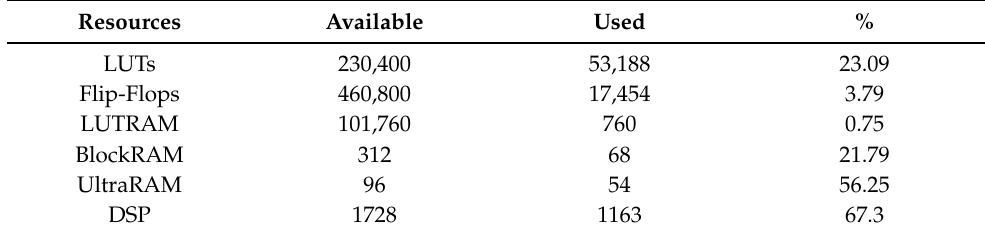
Table 4. Zynq Ultrascale+ XCZU7EV Resource occupation for the entire system.